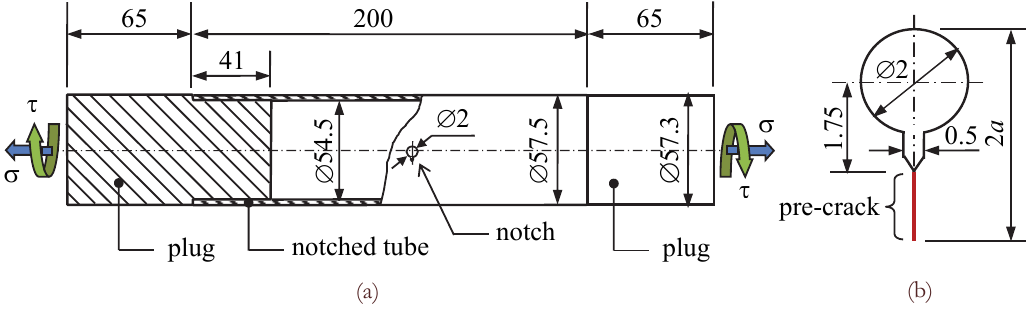
Figure 2: (a) Illustration of a tubular specimen for FCG test under cyclic tension and torsion. (b) The crack start notch with a single- sided mode I pre-crack. (after